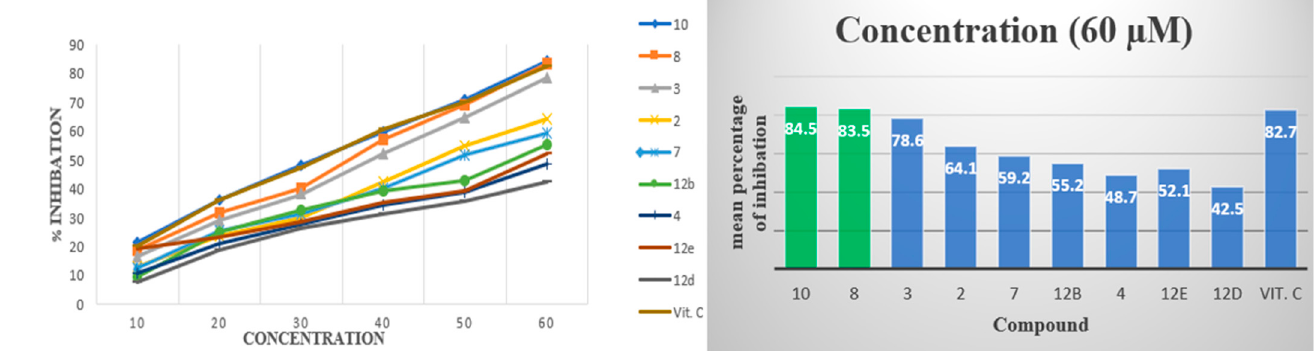
Figure 3. Graphical presentation of considerable antioxidant activity of thiophen-2-ylindole candidates ( 2 , 3 , 4 , 7 , 8 , 10 , 12b , 12d , and 12e ).